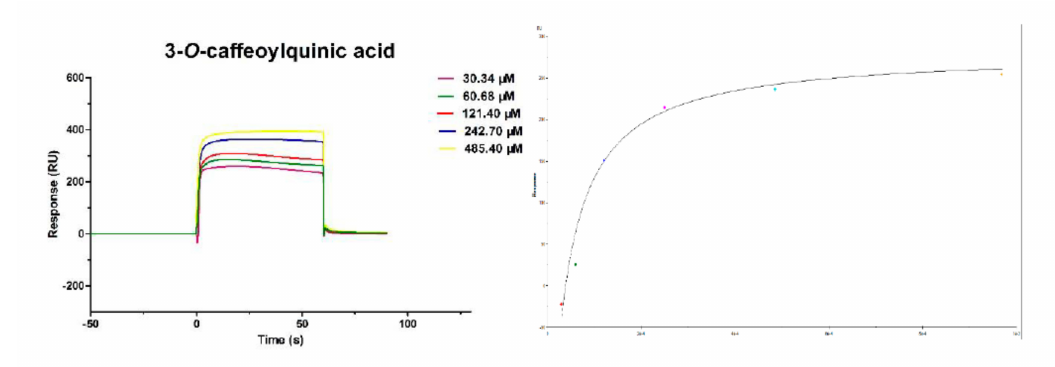
Figure 2. A ffi nity between 3-CQA and TNF-a. A series of concentrations (30.34–485.40 µ M) of 3-CQA were tested to obtain the a ffi nity between TNF- α and 3-CQA by kinetic analysis. The KD value of the interaction between TNF- α and 3-CQA was determined to be 1.38 × 10 − 6 M ( n =